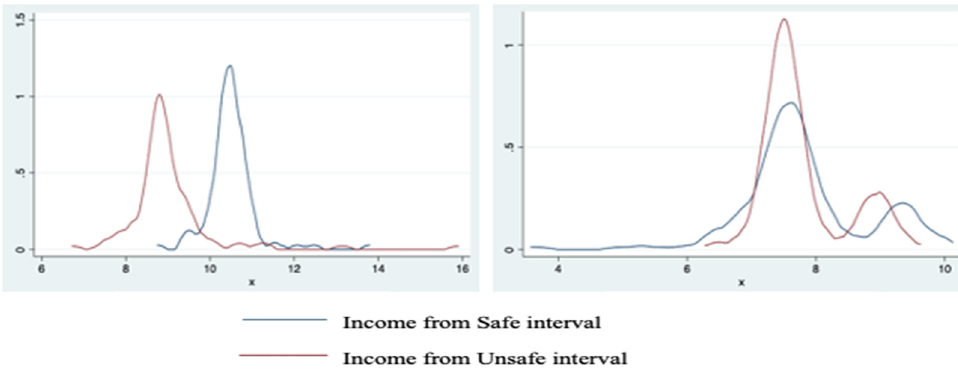
Figure 4. Effects of rice harvesting behaviors in safe interval on the income of rice farmers and rice output.